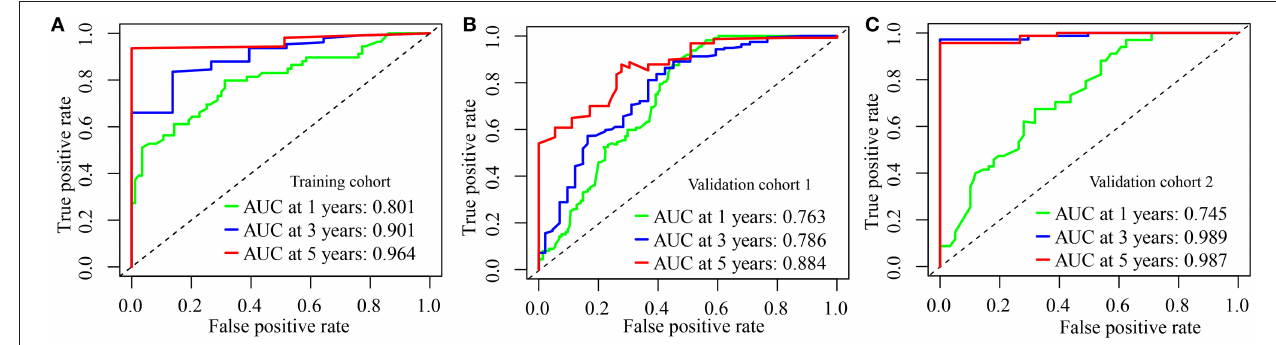
FIGURE 3 | Survival difference between high- and low-risk groups: (A) In Training cohort. (B) In Validation cohort 1. (C) In Validation cohort 2.